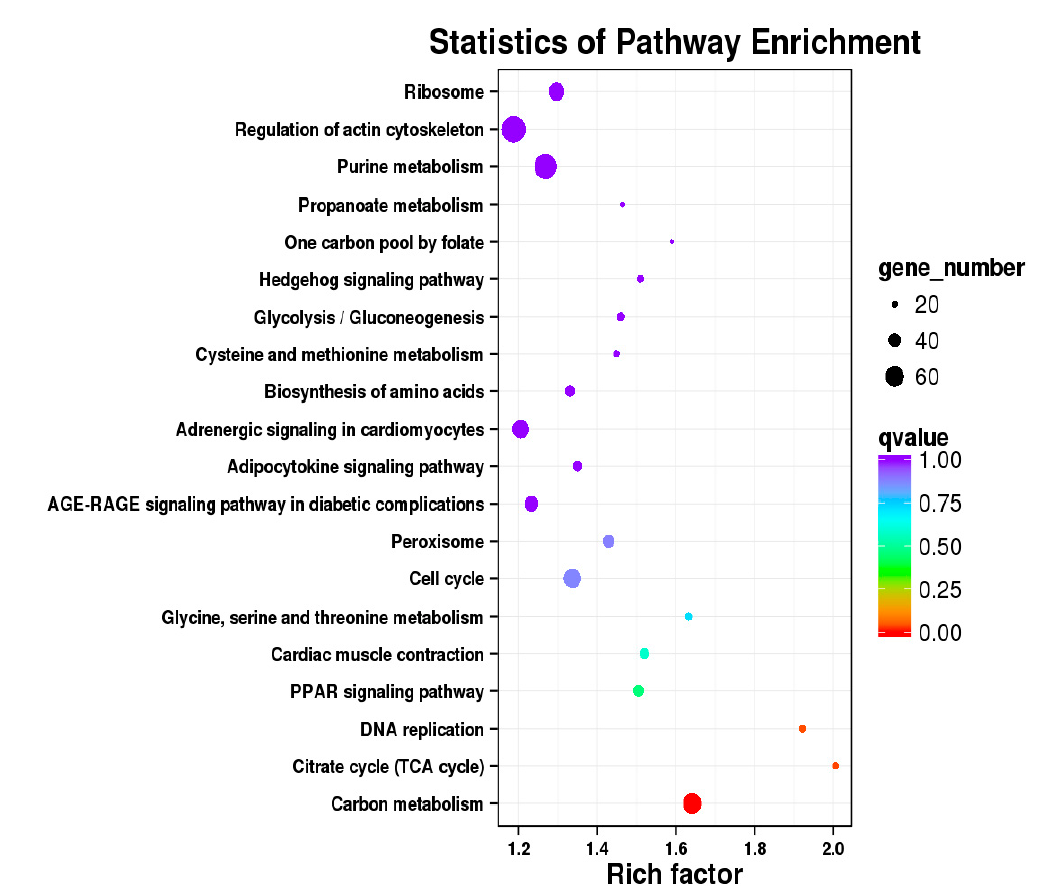
Figure 14. KEGG annotation of DEGs in breast muscle of BE17B_vs_BM6B.